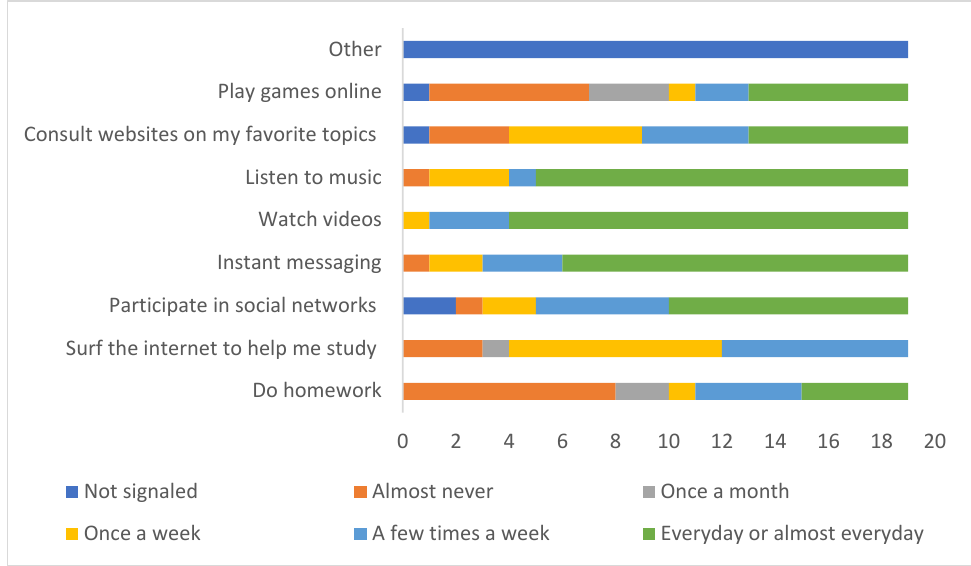
Figure 5. 7th grade s tudent’s activities online .